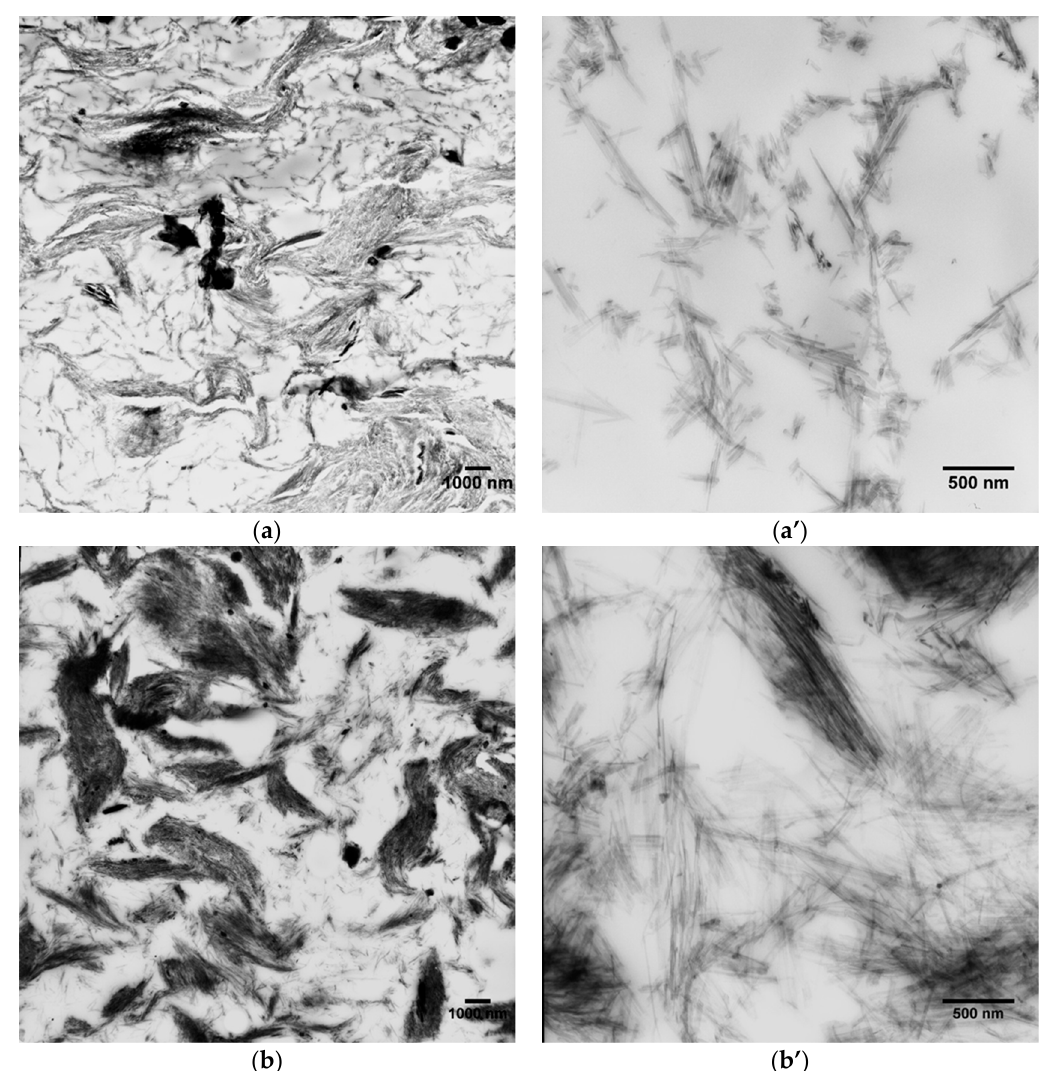
Figure 5. TEM images at different magnifications of ( a , a’ ) SepS9/NR and ( b , b’ ) SepB5/NR biocomposites.